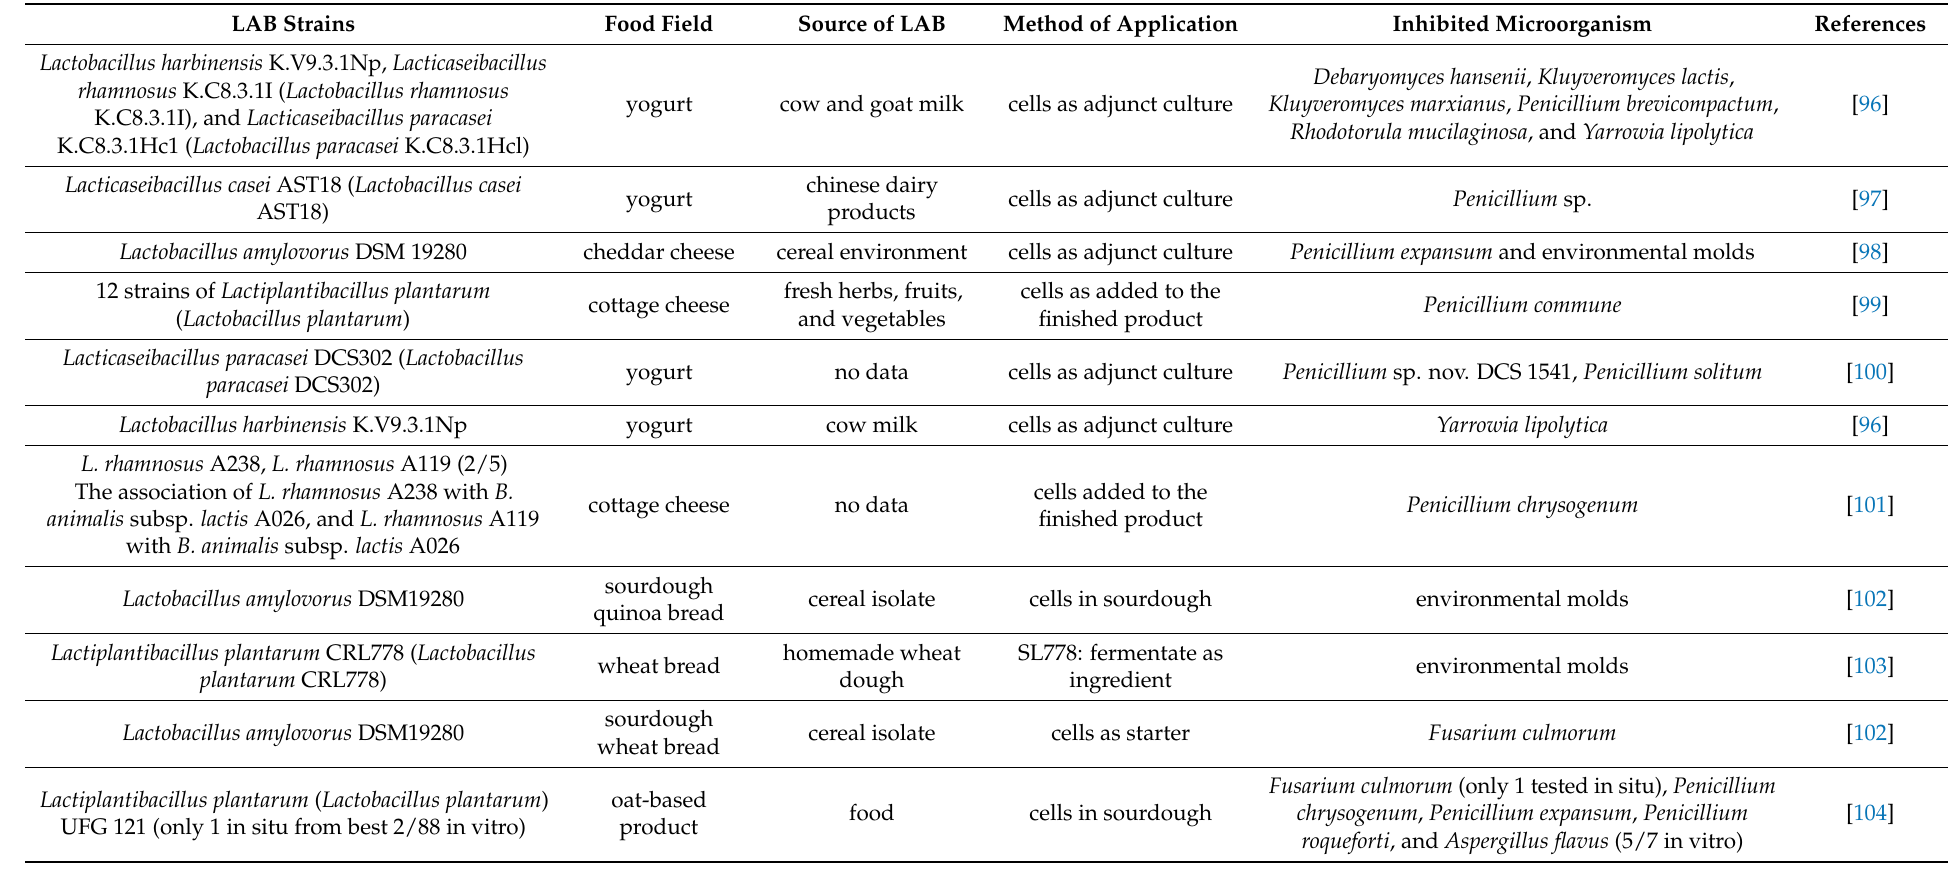
Table 3. The antagonistic activity of selected LAB strains against yeasts and filamentous fungi in selected fermented products. Our own elaboration on the basis of Salas et al.